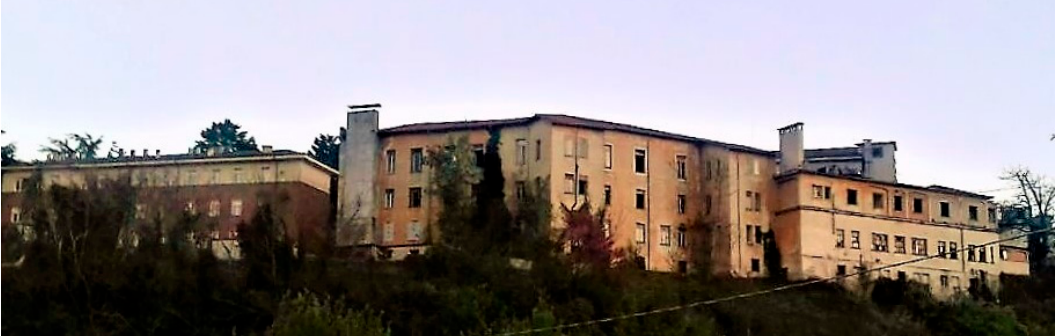
Figure 3. The north face of the former Hospital of S. Salvatore as it currently appears: view from outside the urban walls, L’Aquila.